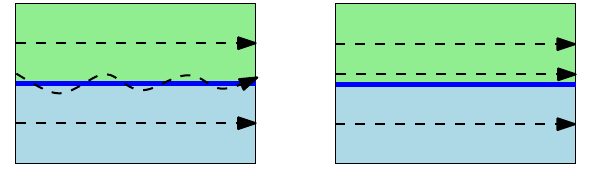
Figure 8: Trajectories (in dashed, black) over a geographic context (in bold, blue).